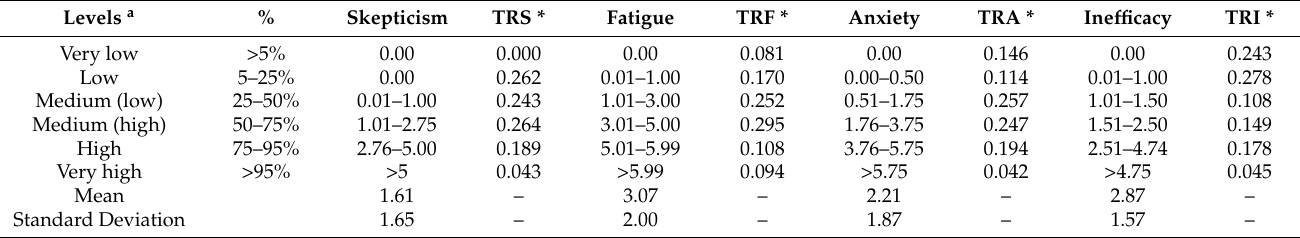
Table 4. Scores correction by levels for the sample of teachers and teachers’ ratio (TR) by technostress dimension ( n = 3006). Levels